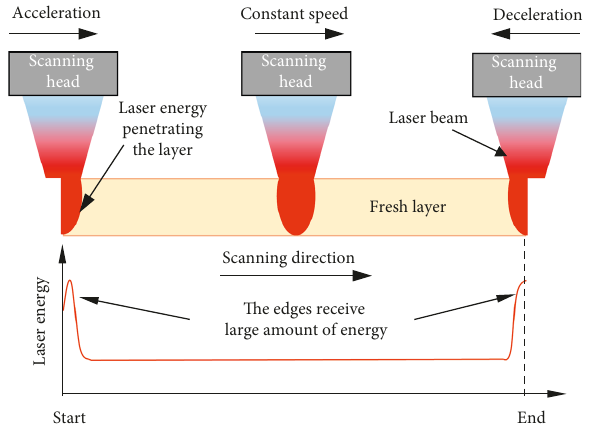
Figure 8: Schematics of the end-of-vector (EOV) effect in the SLS